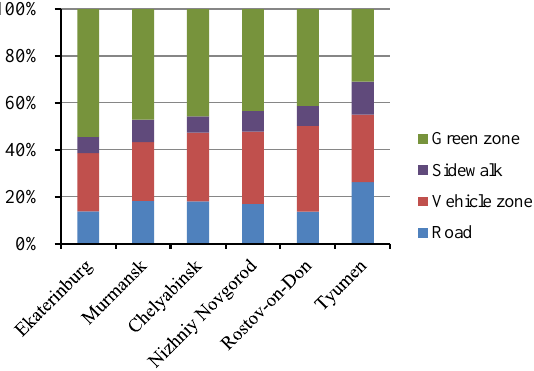
Figure 4. The division of residential quarters into the main types of functional zones.